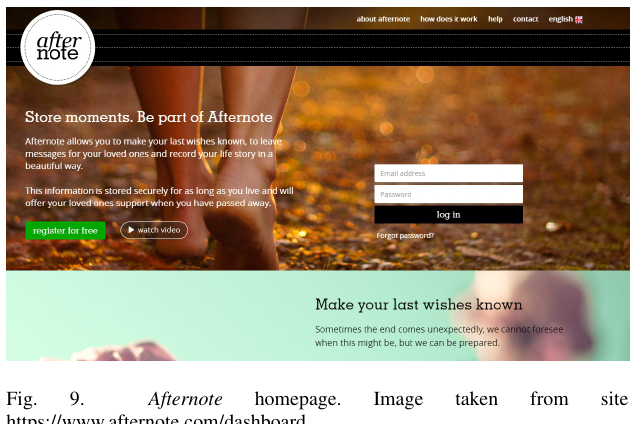
9. Afternote homepage. Image taken from site: